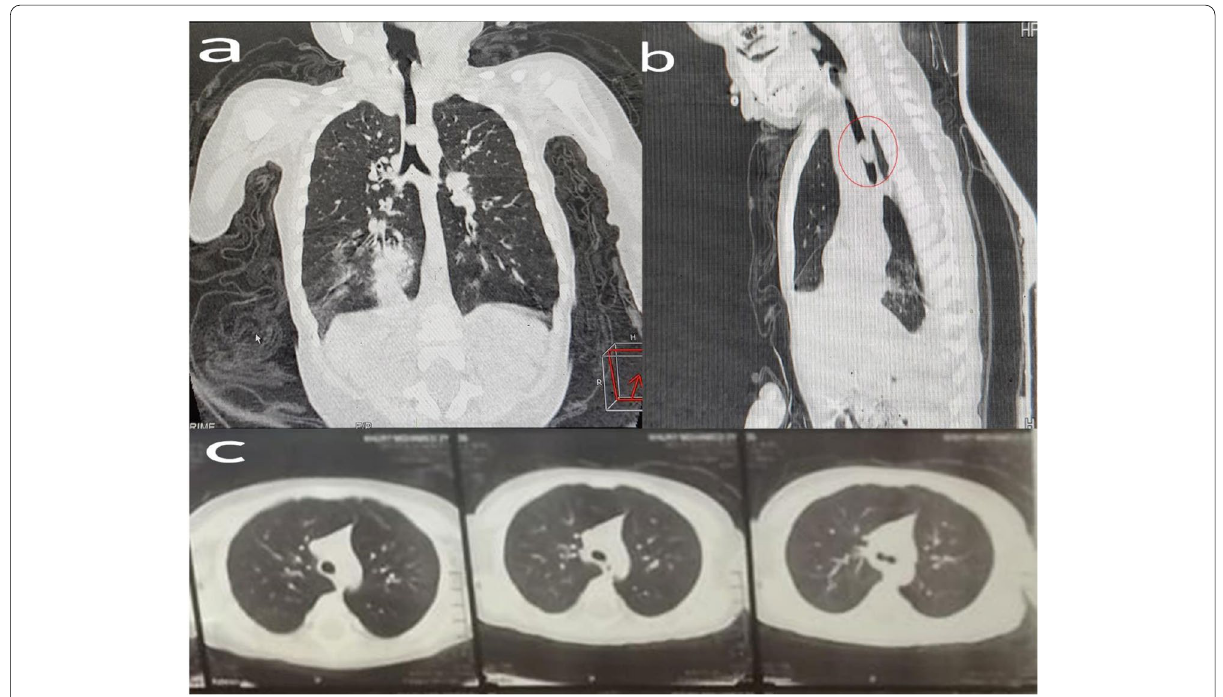
Fig. 1 CT scan showing mass in the trachea with a pneumonic patch in the RLL. a Coronal view b Sagittal view. c 6 months follow-up CT chest (cross-sectional view)